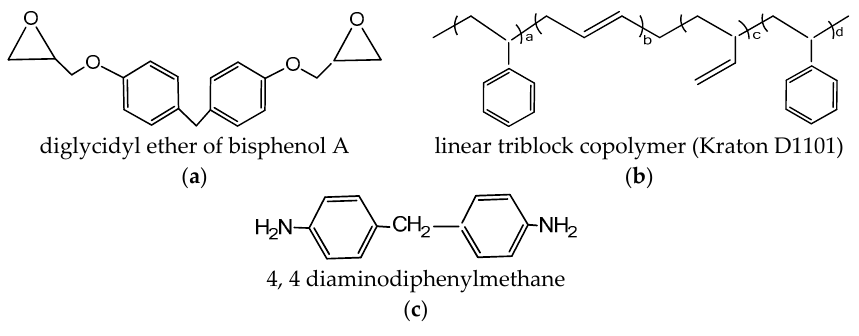
Figure 1. The chemicals used and their structures. ( a ) Diglycidyl ether of bisphenol A (DGEBA); ( b ) linear triblock copolymer (Kraton D1101); ( c ) 4,4 diaminodiphenylmethane (DDM).